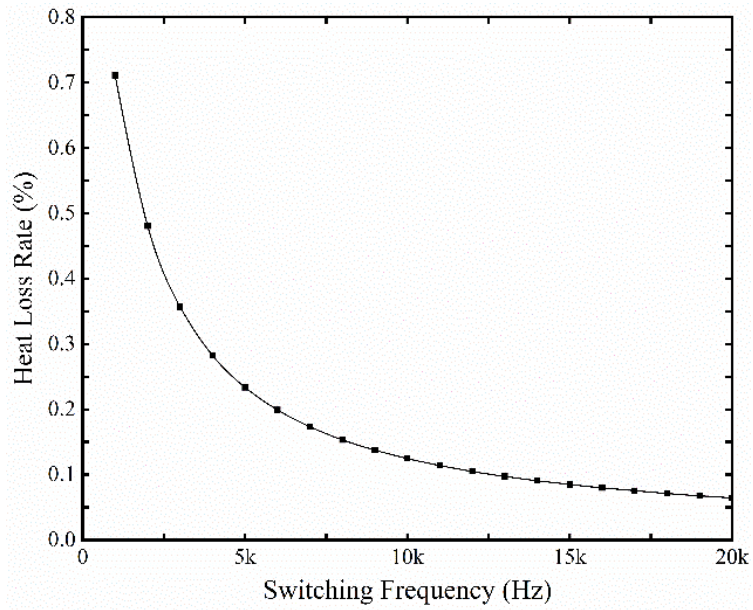
Figure 11. Variation of heat loss rate with switching frequency.